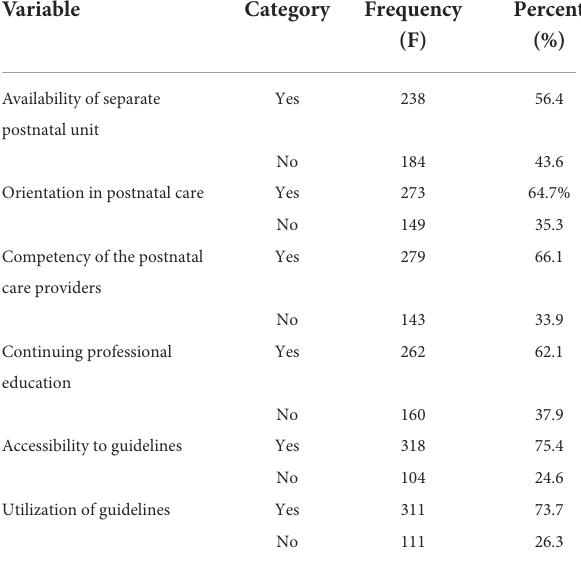
TABLE 2 Postnatal care practices in Ethiopia ( N =